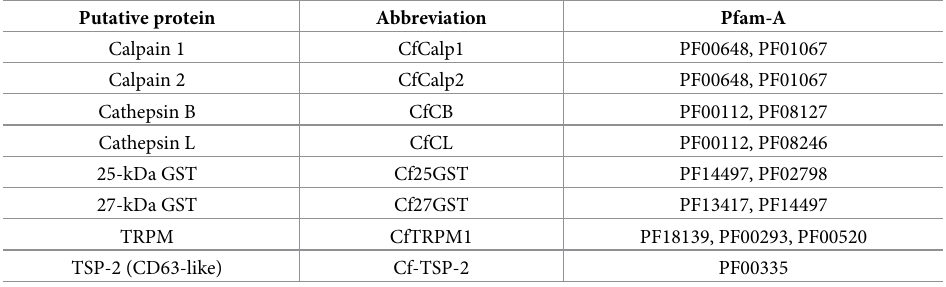
Table 4. Select Cardicola forsteri protein homologs and their predicted conserved structural domains.